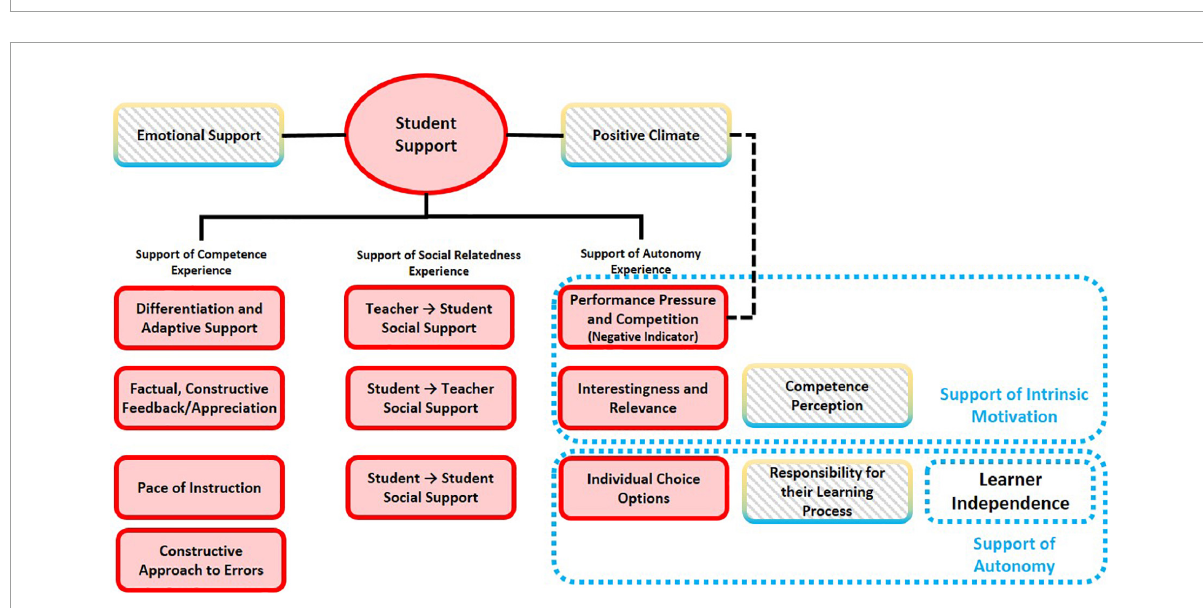
FIGURE4 Suggested adjustments on the measurement framework of Student Support according to the comparison between conceptual indicators and empirical measurement